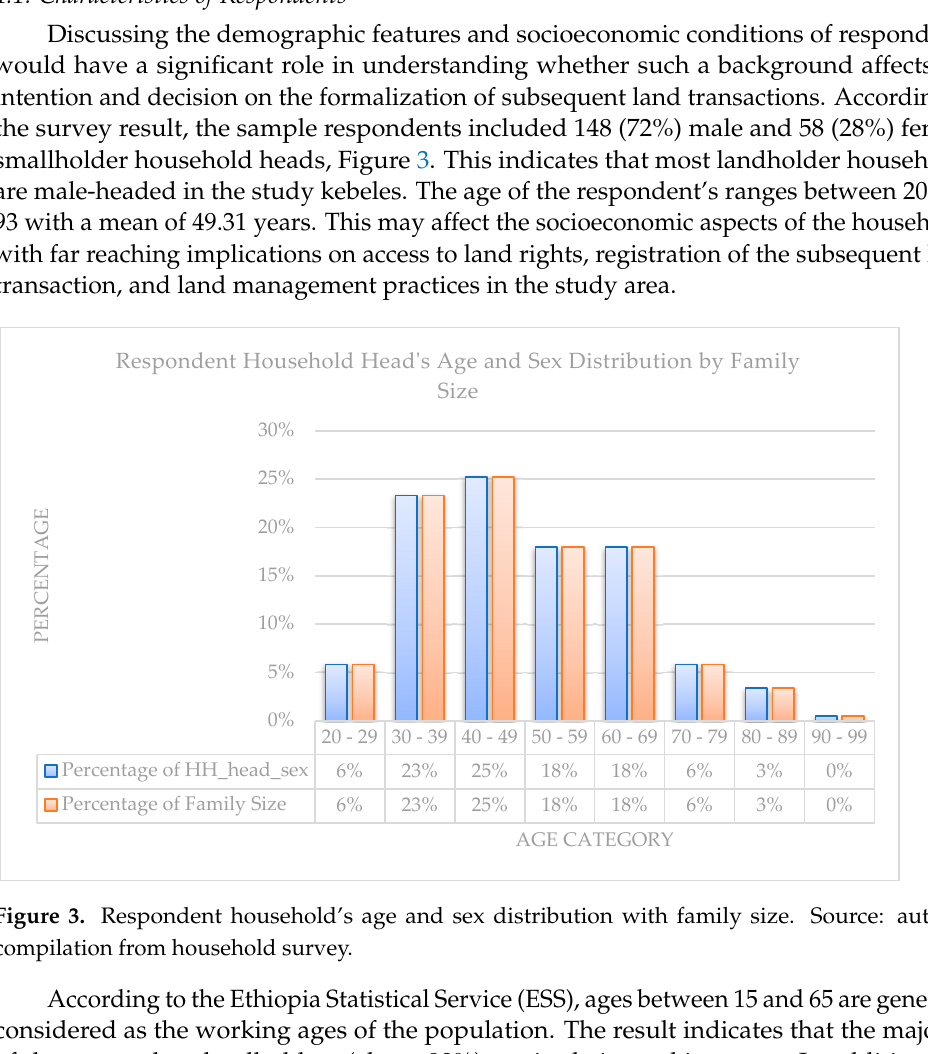
Table 2. Respondent’s Marital and Educational Status by Sex. Source: Authors’ Compilation from the household survey.